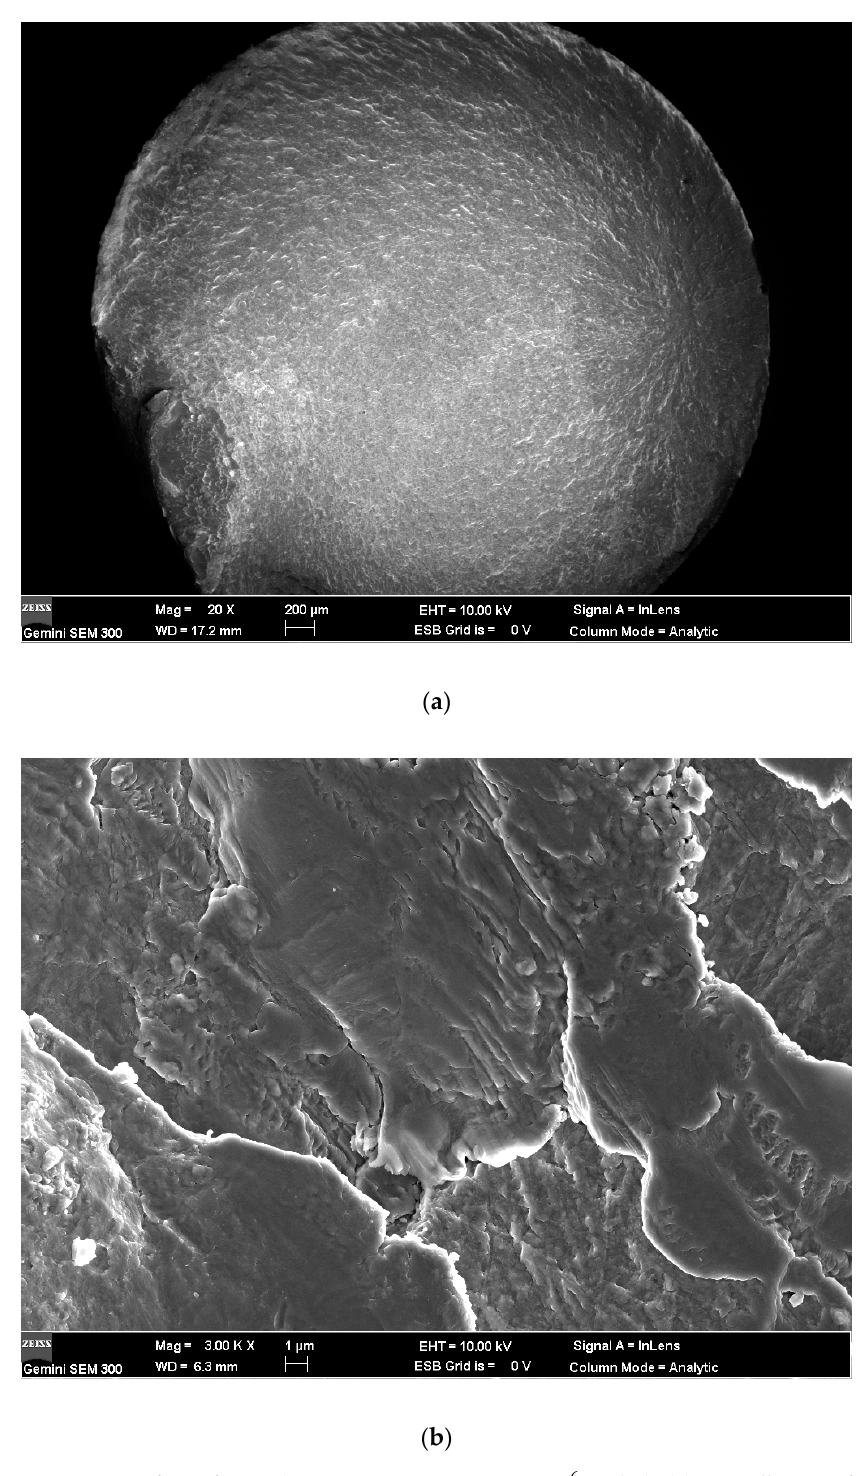
Figure 9. Fracture surface of TLM (UI-48000, 500 MPa, 4.97 × 10 6 cycles): ( a ) Overall view of fracture surface; ( b ) slip trace of crystals in the crack initiation.